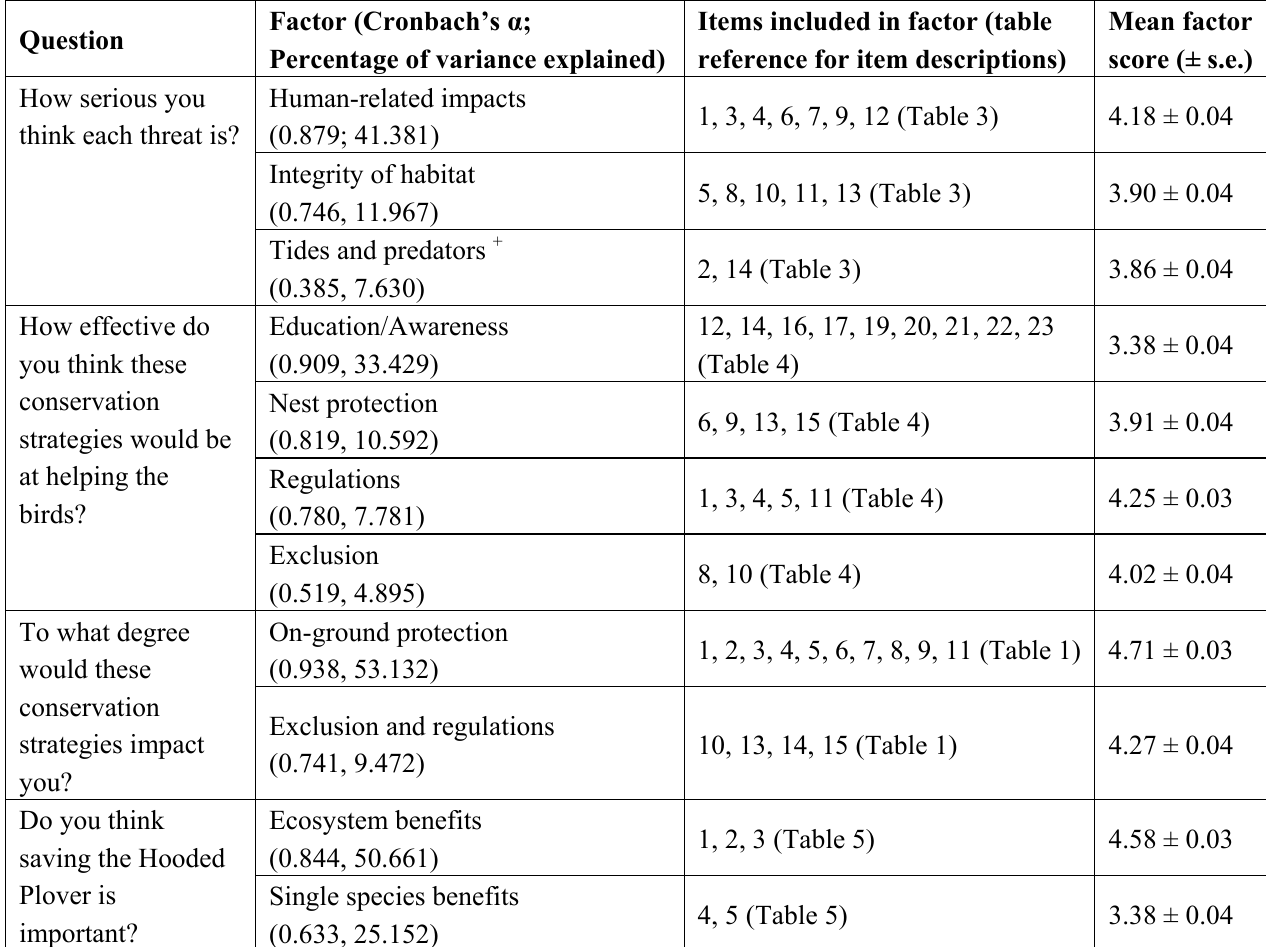
Table 2. Summary of factor analysis results for four questions regarding threats and conservation management for the Hooded Plover. The factors (themes) described by each analysis, the questionnaire items these encompass and summary statistics are provided. Full item descriptions can be cross-referenced from the relevant tables as indicated. Mean factor scores are provided and these are plotted in Figure